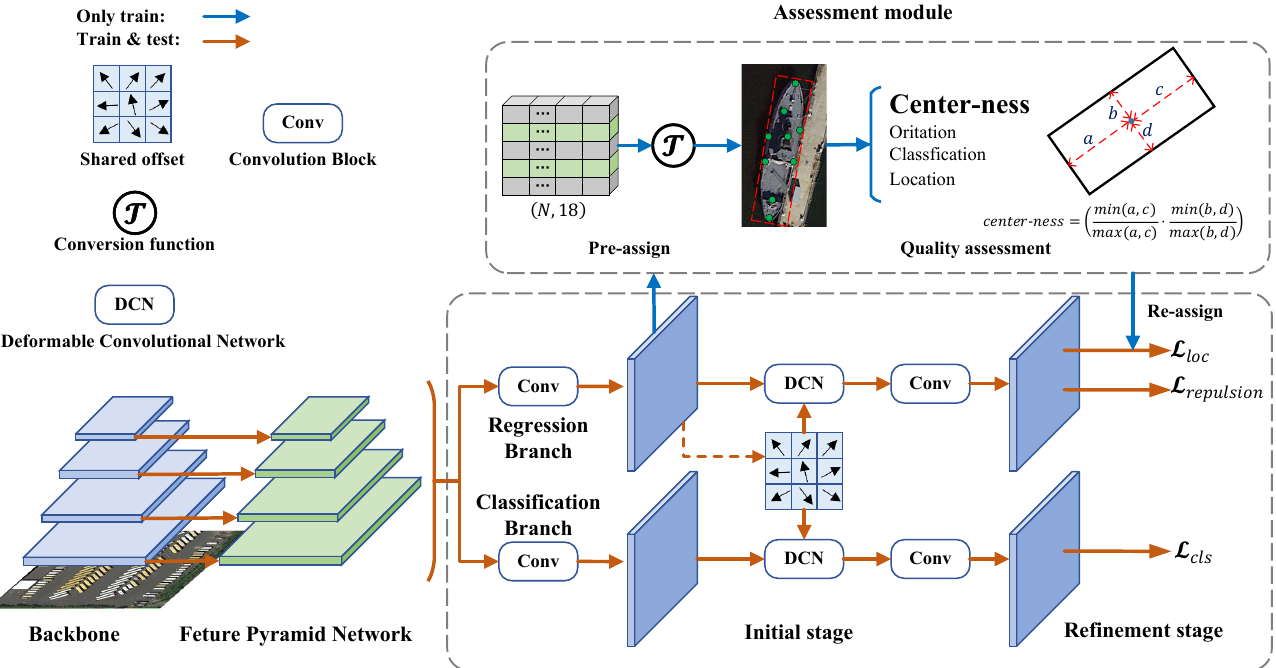
Figure 2. The pipeline of our proposed object detector. The proposed method is an anchor-free detector based on Reppoint [24] with adaptive point sets as the representation of an oriented bounding box, where a classical backbone with FPN [12] network is employed to encode multi-scale features. Deformable Convolutional Network (DCN) is utilized to capture shape-aware features. To cope with the harmony of the classification branch and the regression branch, the offset parameter is shared in the DCN